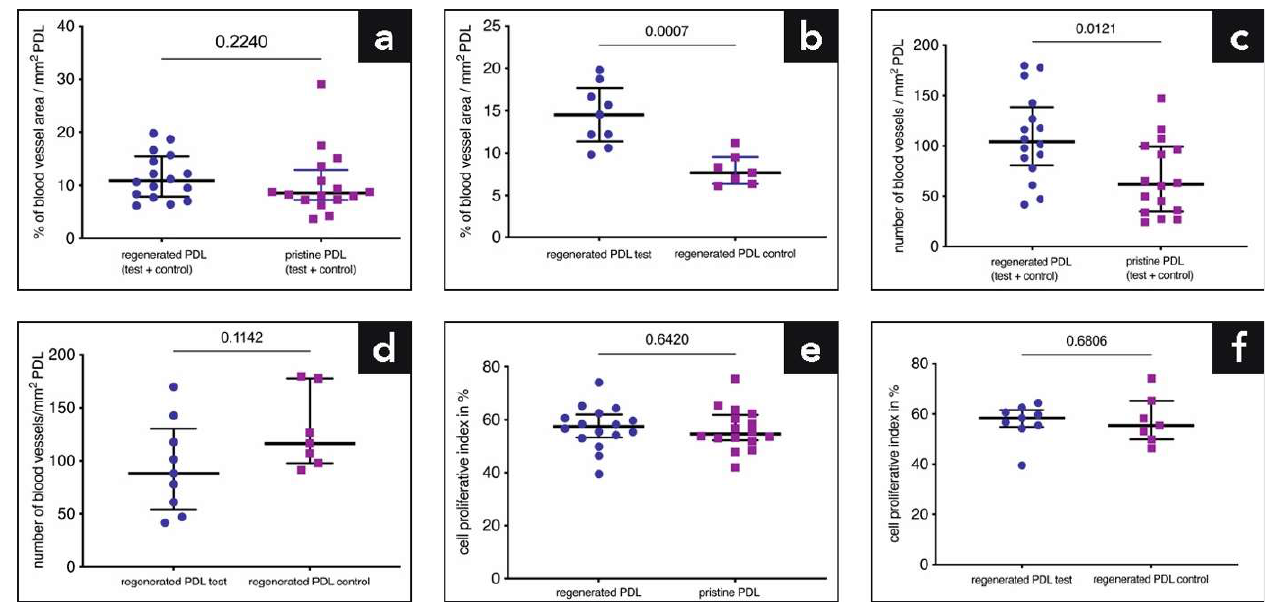
Figure 7. ( a , b ) Graphs illustrating the percentage of blood vessel area per mm 2 periodontal ligament (PDL); ( c , d ) Graphs illustrating the number of blood vessels per mm 2 PDL; ( e , f ) Graphs demonstrating the cell proliferative index (i.e., number of proliferative cell nuclear antigen positive cells vs. total number of cells in percentage). The bars depict the median and the whiskers the interquartile range. Each dot represents a quantitatively analyzed PCNA stained section.